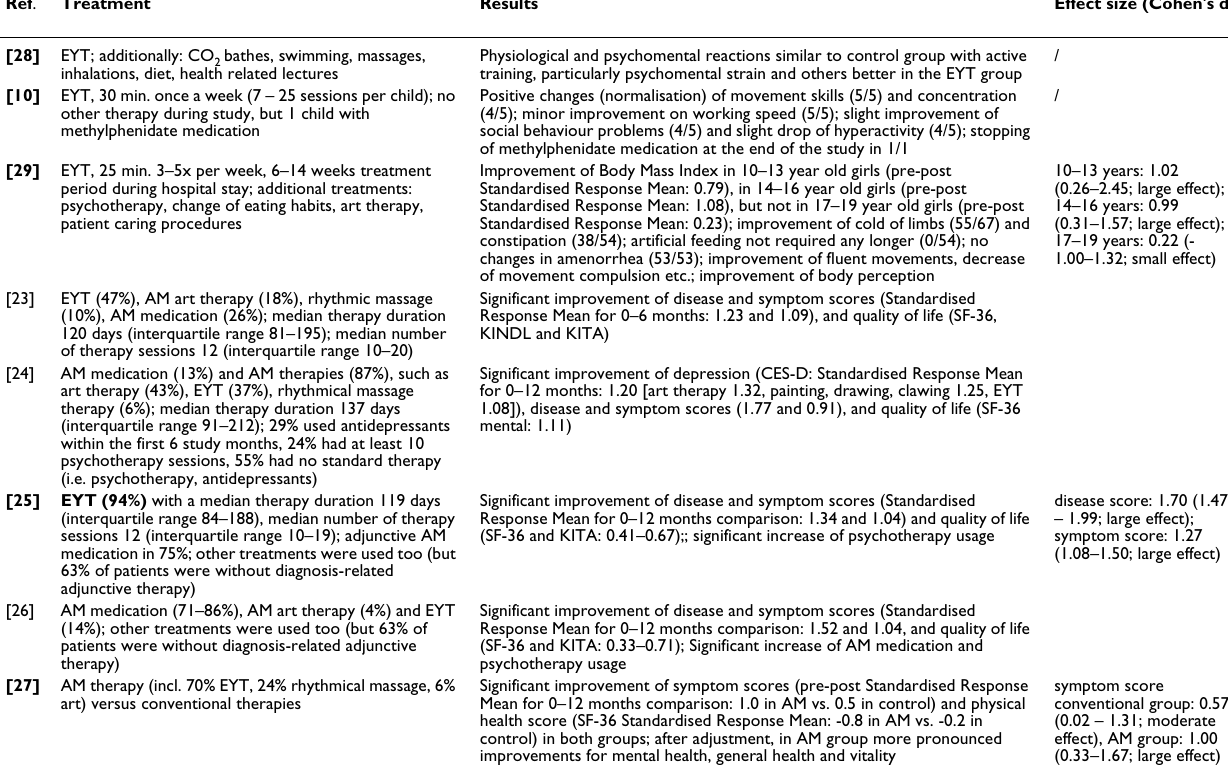
Table 3: Clinical studies enrolling therapeutic eurythmy (with and without add-on treatments) Ref .